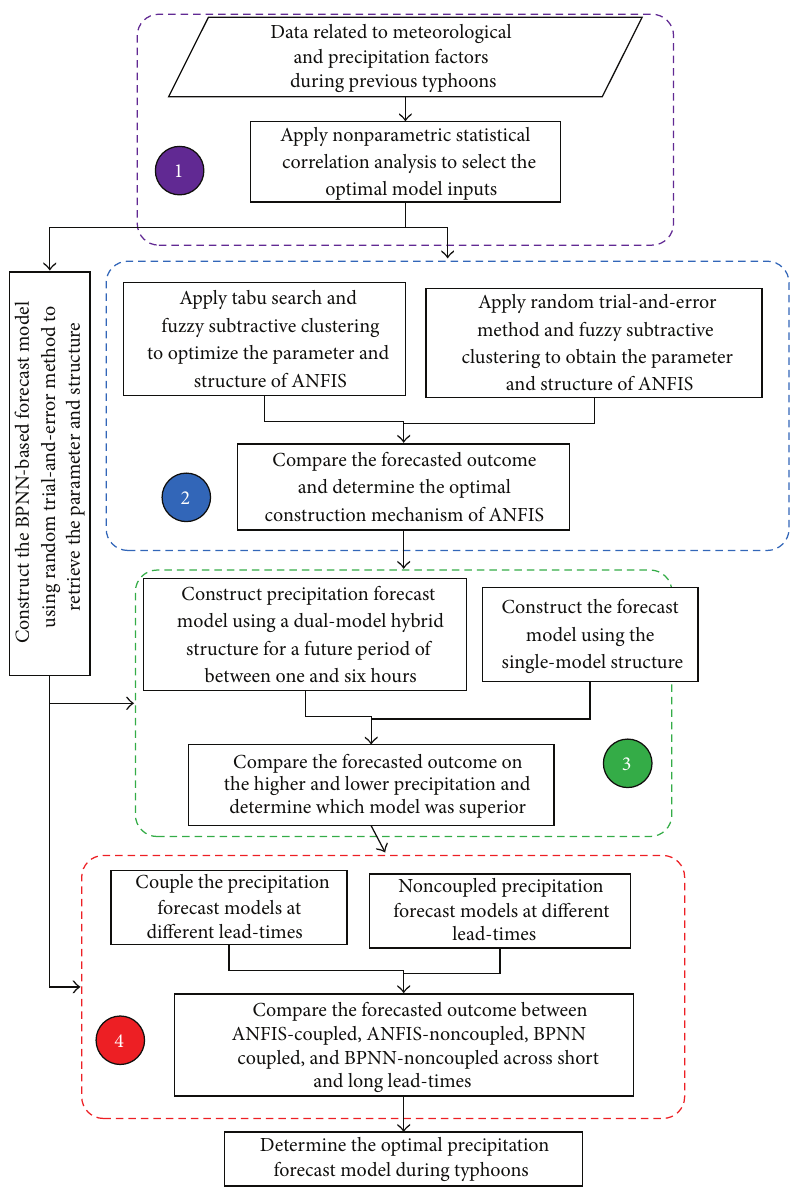
Figure 1: Flowchart of the